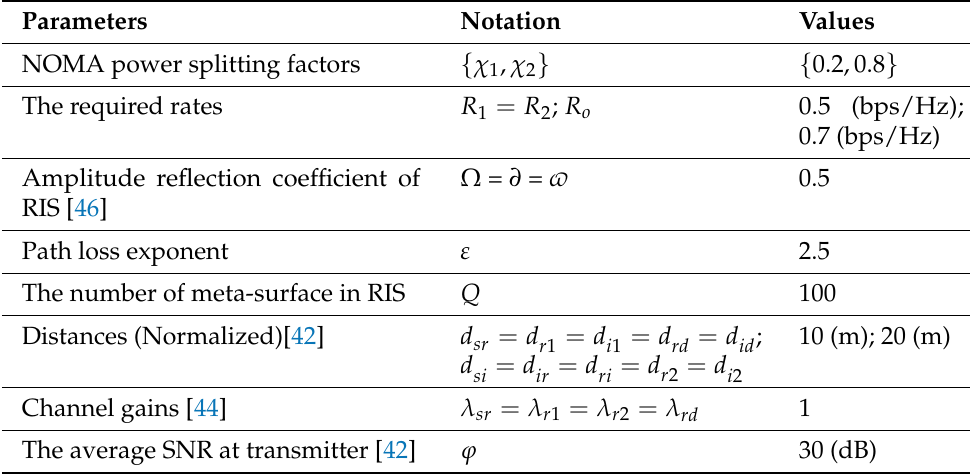
Table 3. Values used in